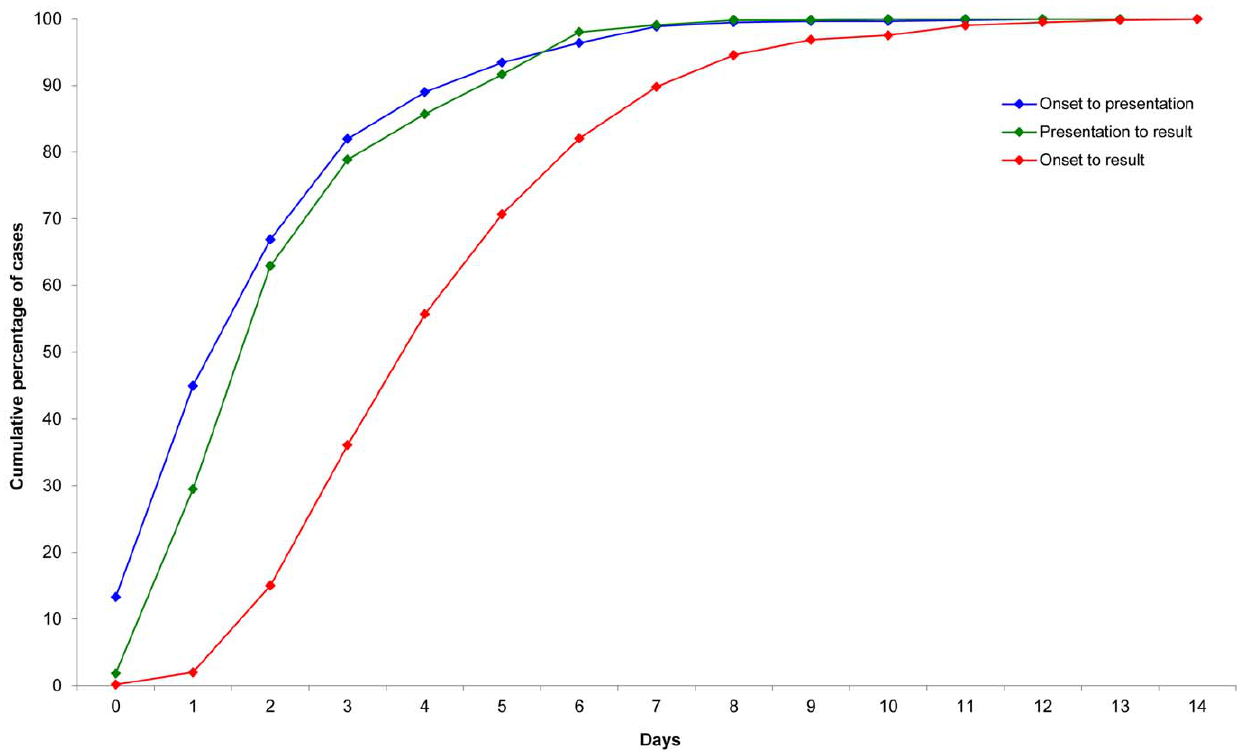
Figure 4. Confirmed influenza A(H1N1)pdm09 cases aged 5–17 years by days from onset to specimen collection and test result, Victoria, 2009.